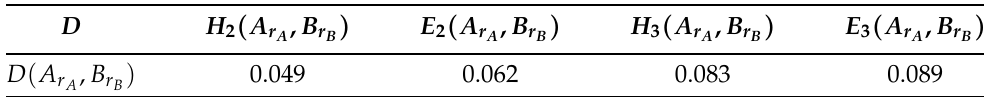
Table 2. Comparison of the four different